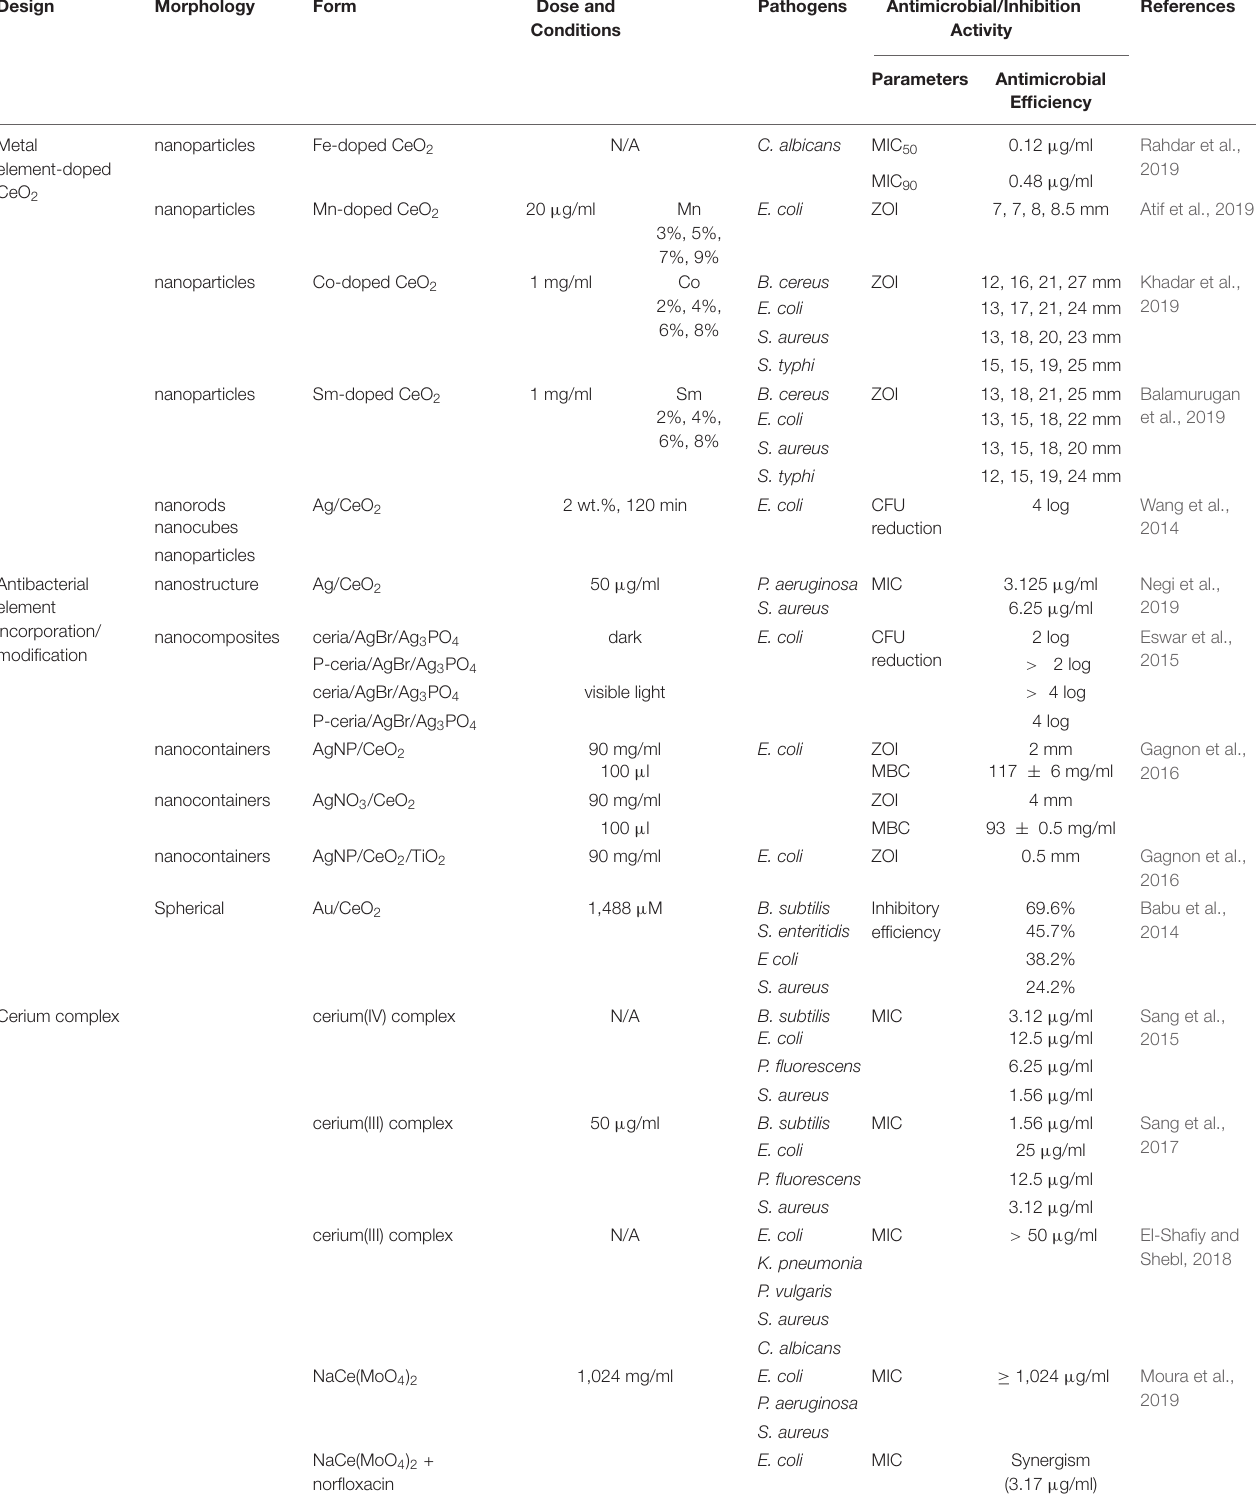
TABLE 2 | The antimicrobial activities of element-doped CeO 2 , antibacterial element incorporation/modification, and cerium complexes.